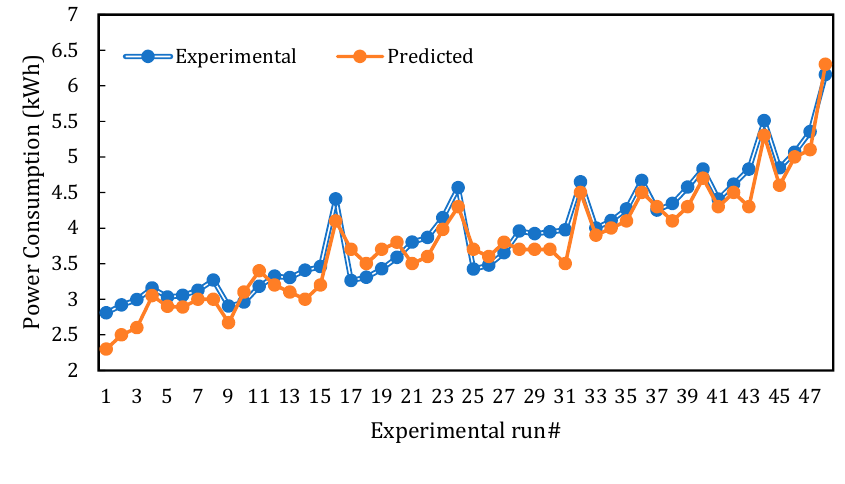
Figure 4. Predicted versus experimental runs: ( a ) Rz; ( b ) MRR; ( c ) VB; ( d ) power consumption (modeling step using BPNN).